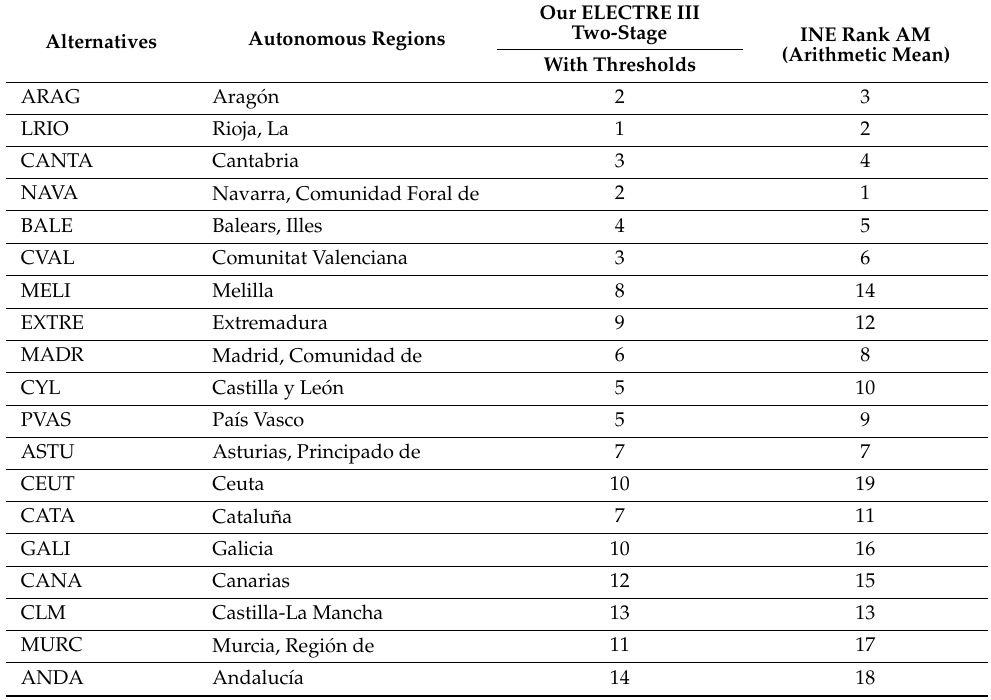
Table 10. Comparison between our result (ELECTRE III with all weights equal to 1 and no thresholds) and INE result (arithmetic mean).